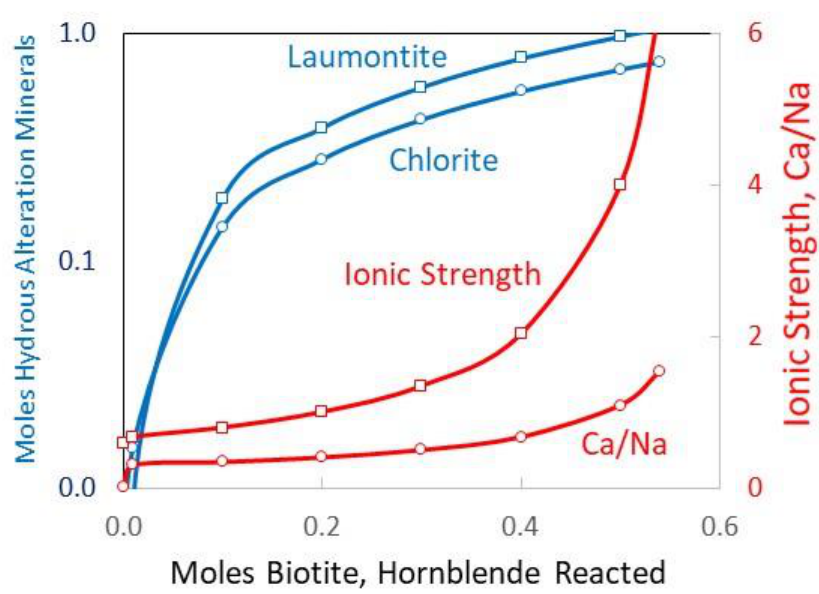
Figure 1. Calculated granite hydrolysis trends at 100 °C. Points are model-calculated values.